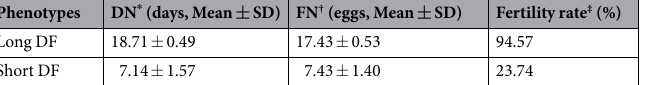
Table 1. Duration of fertility trait in hens. For all phenotypes, we examined multiple inseminations (n = 7). * DN: the days post-insemination until the last fertile egg (up to about 40 wks of age); † FN: the numbers of fertile eggs laid after artificial insemination (AI) (up to about 40 wks of age); ‡ % fertility = number of fertile eggs/number of total eggs produced or set.